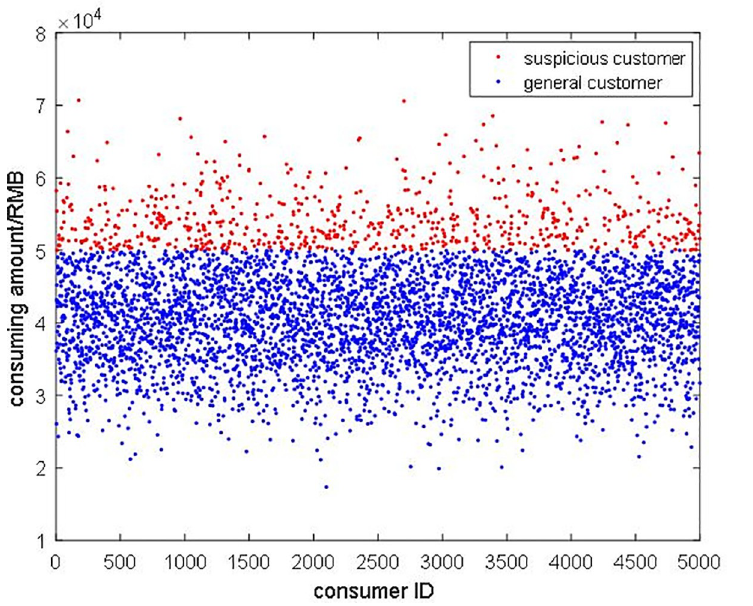
Fig 9. The personal consuming amount before regulation.